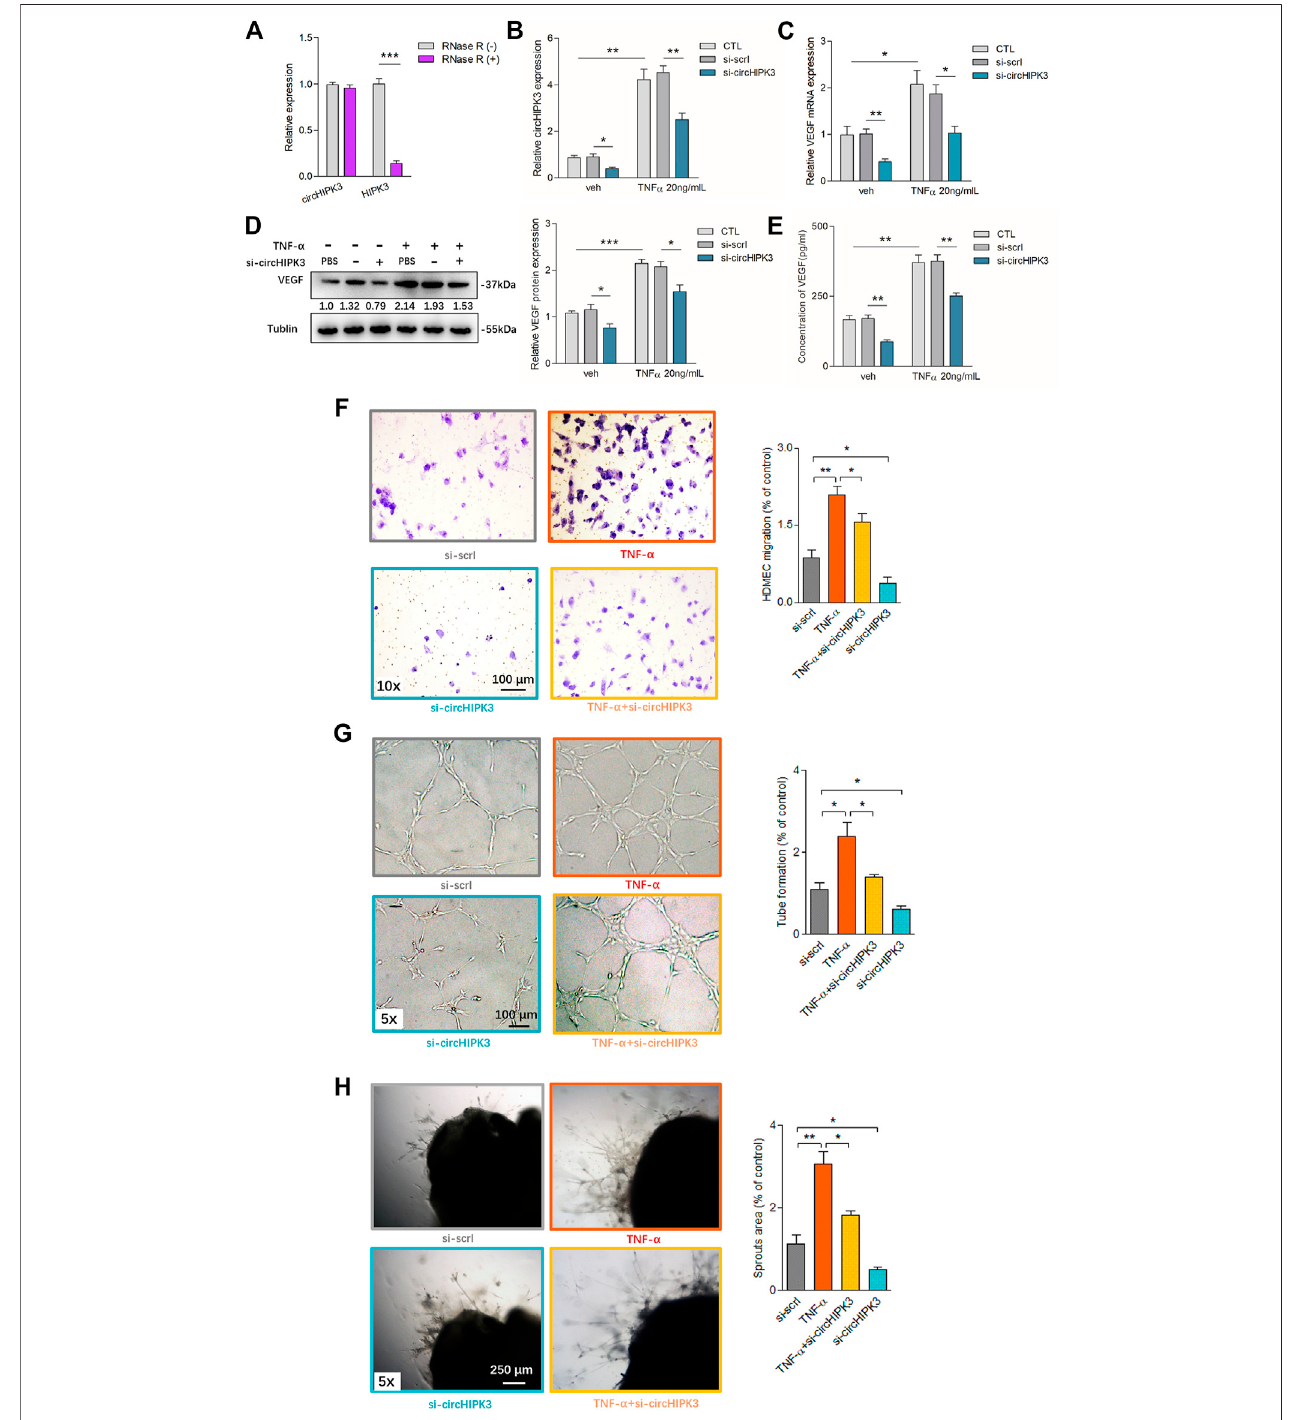
FIGURE 1 | Overexpression of circHIPK3 in RA-FLS induced by TNF- α , and knockdown of circHIPK3 inhibited the VEGF production of RA-FLS. (A) CircHIPK3 couldresistthedigestionofRnaseR(n (cid:1) 3;*** p < 0.001). (B) TheexpressionofcircHIPK3couldbesigni fi cantlyupregulatedbyTNF- α inductionfor48 h,andsigni fi cantly reducedby circHIPK3 knockdown whether TNF- α addition wasperformed or not(n (cid:1) 3;* p < 0.05, ** p < 0.01). (C – E) The effects ofcircHIPK3silencing on VEGF mRNA (C) and protein (D) expression in co-cultured RA-FLS; VEGF concentration in co-culture ’ s supernatants (E) were determined by qRT-PCR, Western blot, and ELISA,respectively.VEGFexpressionwassigni fi cantlyupregulatedafterTNF- α induction,andsigni fi cantlydownregulatedbycircHIPK3knockdowncomparedtothose from the control group whether TNF- α was added or not (n (cid:1) 3; * p < 0.05, ** p < 0.01, *** p < 0.001). (F – H) The transwell assay (F) and tube formation test (G) for 6 h as well as ex vivo aortic ring angiogenesis assay (H) demonstrated signi fi cant changes in migration, the capillary-like structure formation of HDMECs and microvessel sprouting,respectively,inaccordancewithVEGFexpression insupernatants from RA-FLSand HDMECco-cultures (n (cid:1) 3;* p < 0.05,** p < 0.01).Results areexpressed as the mean ± S.E.M. Veh (cid:1) vehicle control. CTL (cid:1) PBS control group. si-scrl (cid:1) scramble siRNA. TNF- α (cid:1) 50 ng/ml.